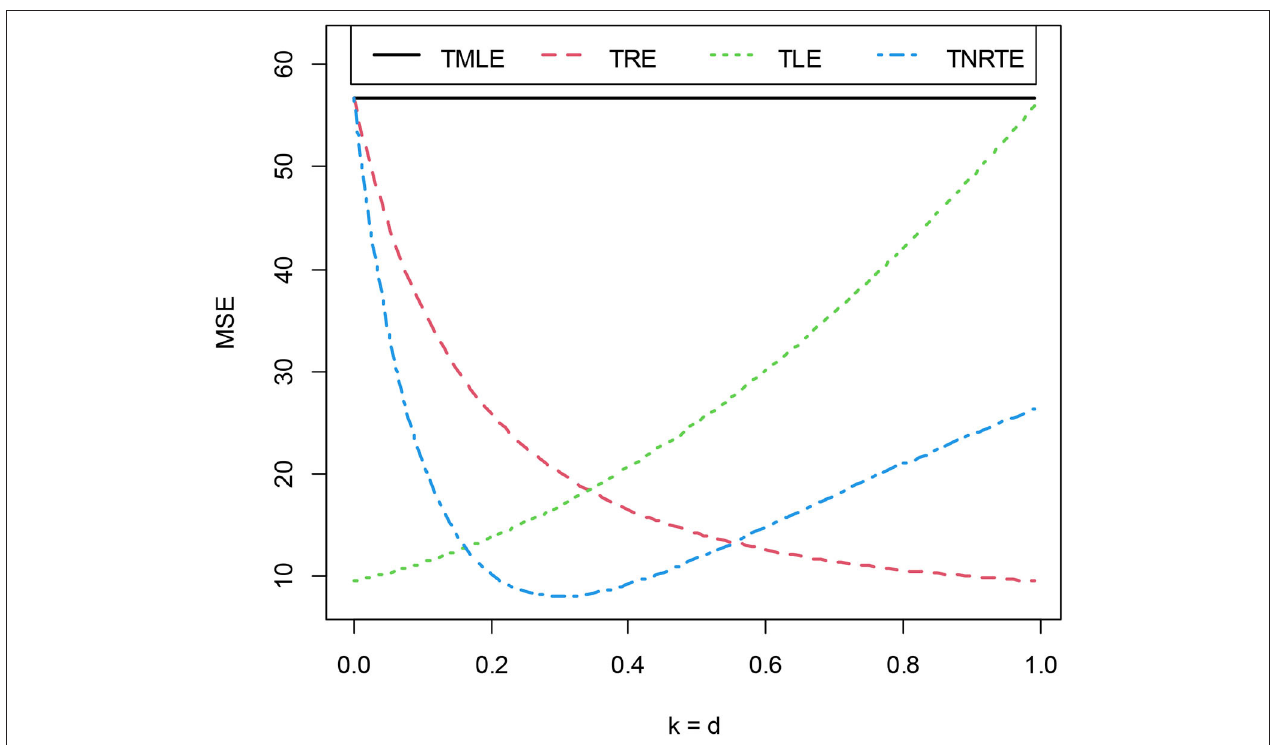
FIGURE 1 | MSE of TMLE, TRE, TLE, and TNRTE for diffrent k, d